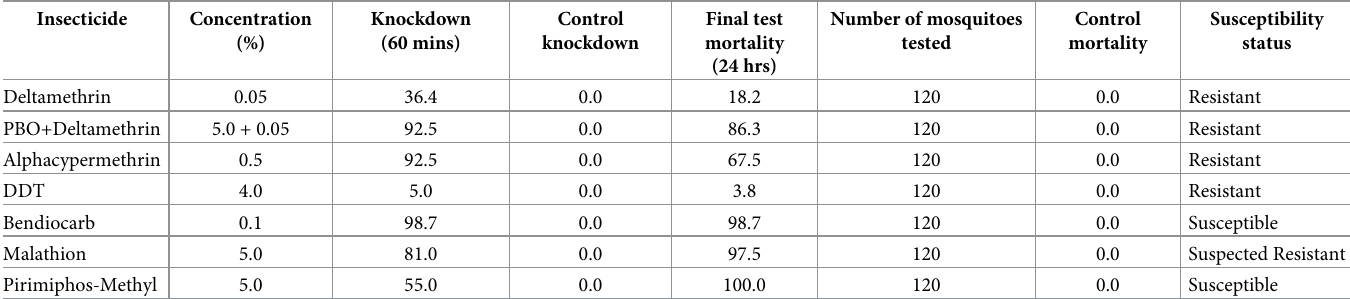
Table 6. Insecticide susceptibility tests status of wild An . gambiae